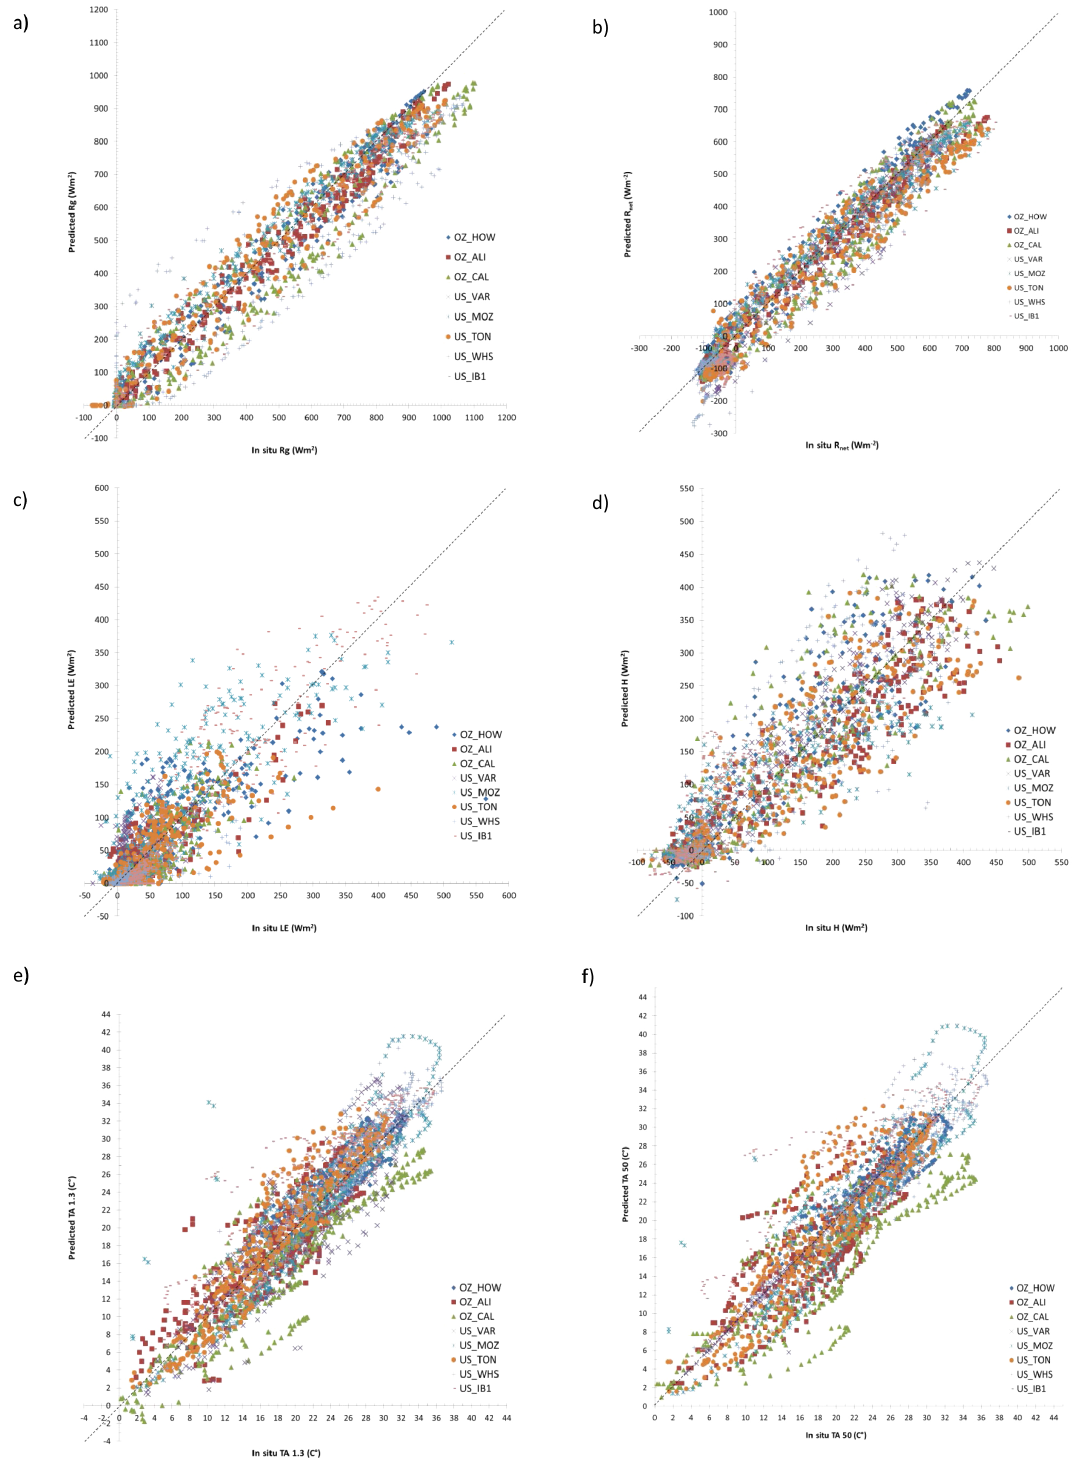
Figure 2. Scatterplot comparison of SimSphere-predicted and in situ (a) R g flux, (b) R net flux, (c) LE flux, (d) H flux, (e) T air 1.3 m , and (f) T air 50 m